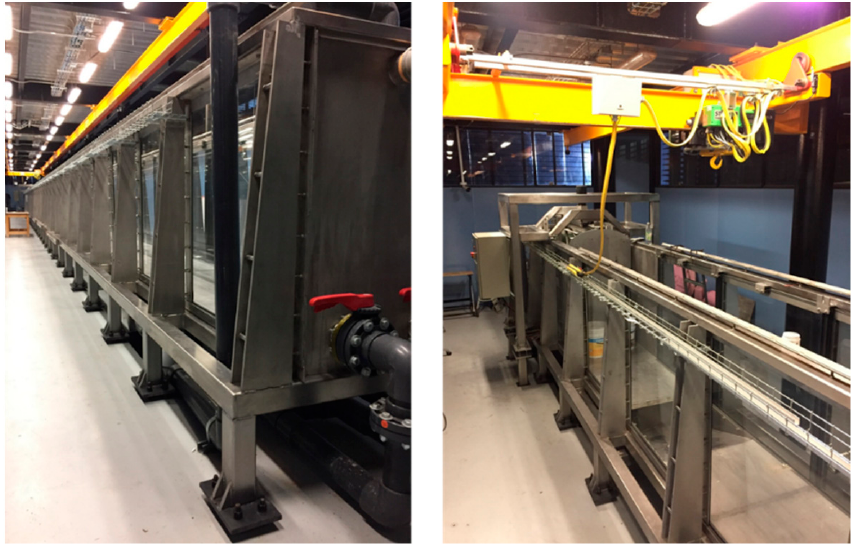
Figure 7. Flow tank facility, Laboratory of Coasts and Ports, UNAM, Mexico City.